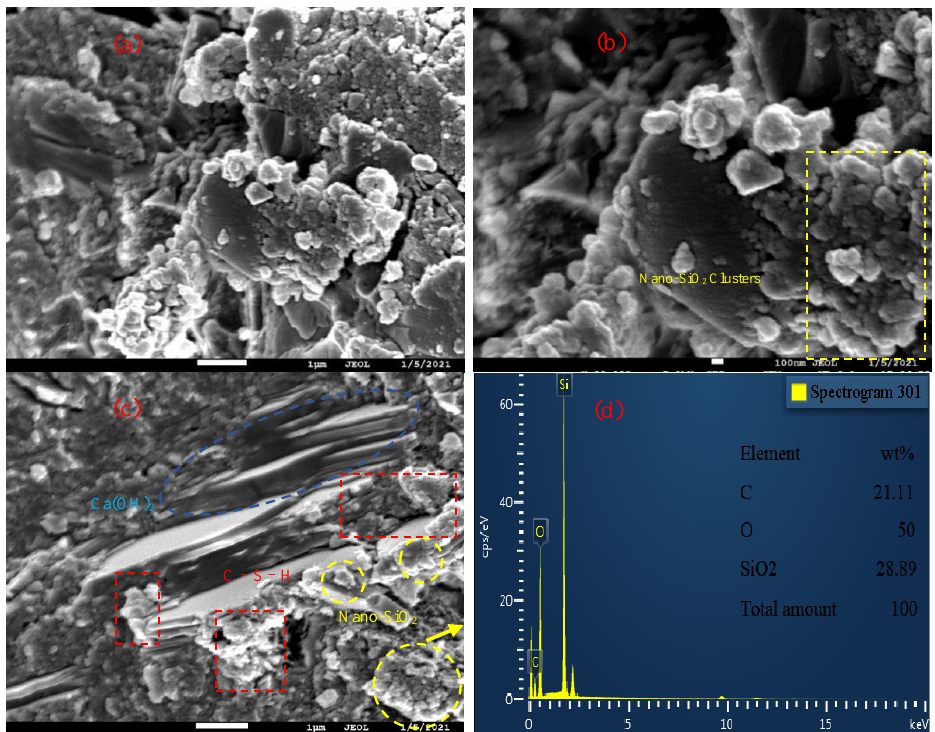
Figure 8. SEM micromorphology of the P·O 42.5 cement hydration products at curing ages of 28 days: ( a – c ) “secondary hydration reaction” between nanosilica particles and calcium hydroxide; ( d ) EDS image of nanosilica sol clusters (the test points are taken from ( c )).